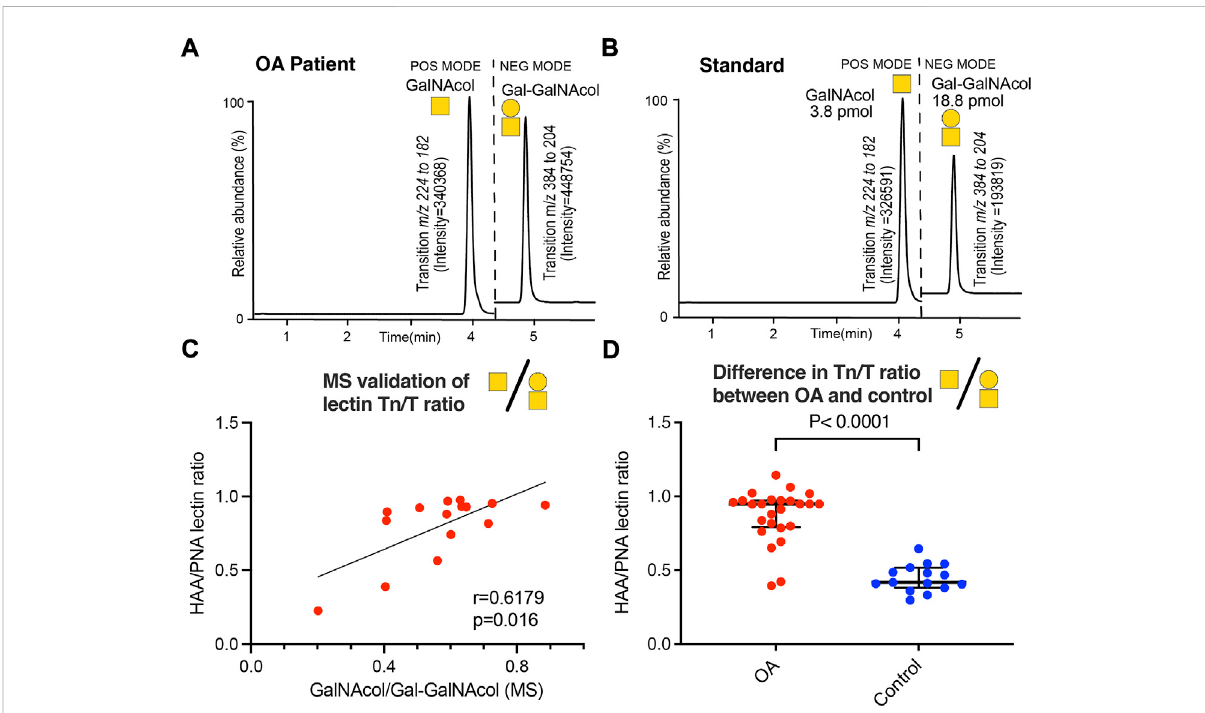
FIGURE 2 Determination of Tn and T antigens on SF-lubricin. (A) Example of LC-SRM MS of released Tn antigen measured as GalNAcol and T antigen measured as Gal β 1-3-GalNAcol from an OA patient. (B) Example of LC-SRM MS of GalNAcol and Gal β 1-3-GalNAcol from standards. (C) Correlation between TnandTantigens usingMSorlectins,where thelevelofTn antigen(GalNAc α 1-Ser/Thr)wasmeasuredusing thelectinHAA andthelevel of Tantigen(Gal β 1-3GalNAc α 1-Ser/ThrwasmeasuredusingthePNAlectinusing patients diagnosedwith OA(n=16). Spearmancorrelationrand signi fi cance P were calculated and displayed in the diagram. (D) Absorbances of HAA-epitopes/PNA-epitopes on SF lubricin were calculated from 29 OA patients and 16 controls using lectin ELISA. Signi fi cance was calculated by a two-tailed nonparametric Mann – Whitney test. Outliers were excluded from prior calculations according to the GOUT test with Q = 0.1. Cartoons of monosaccharide building blocks for representing oligosaccharides according to the SNFG nomenclature; yellow circle = Gal and yellow square =